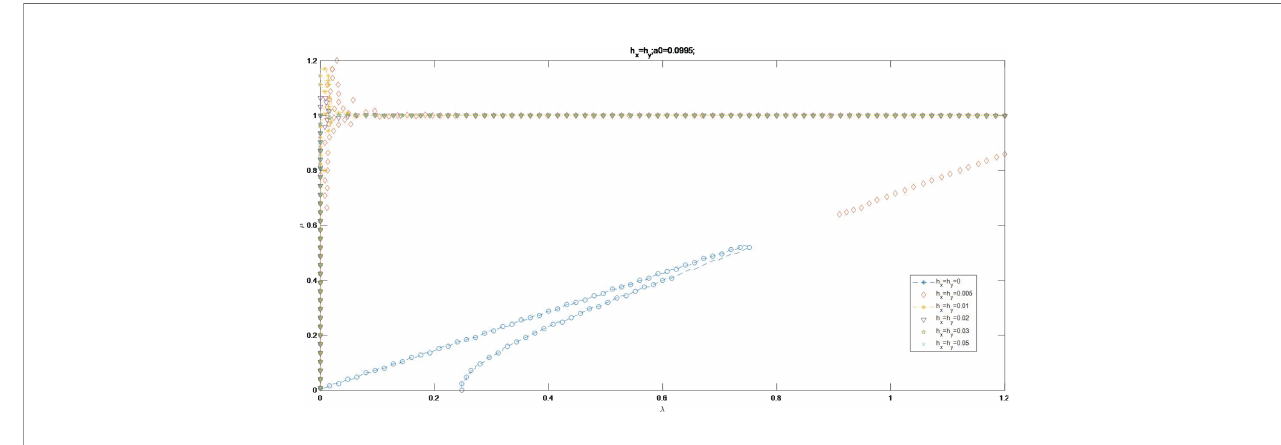
FIGURE 14 | Curves of Im W = 0 for a 0 = 0.0995 and ∂ h ∂ x = ∂ h ∂ y .